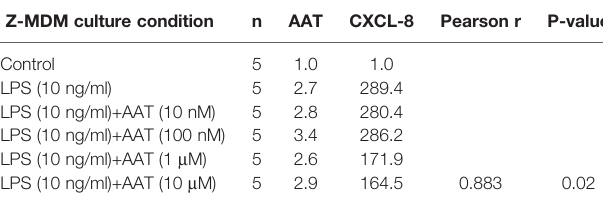
TABLE 2 | Correlation between the expression levels of AAT and CXCL-8. Z-MDM culture condition